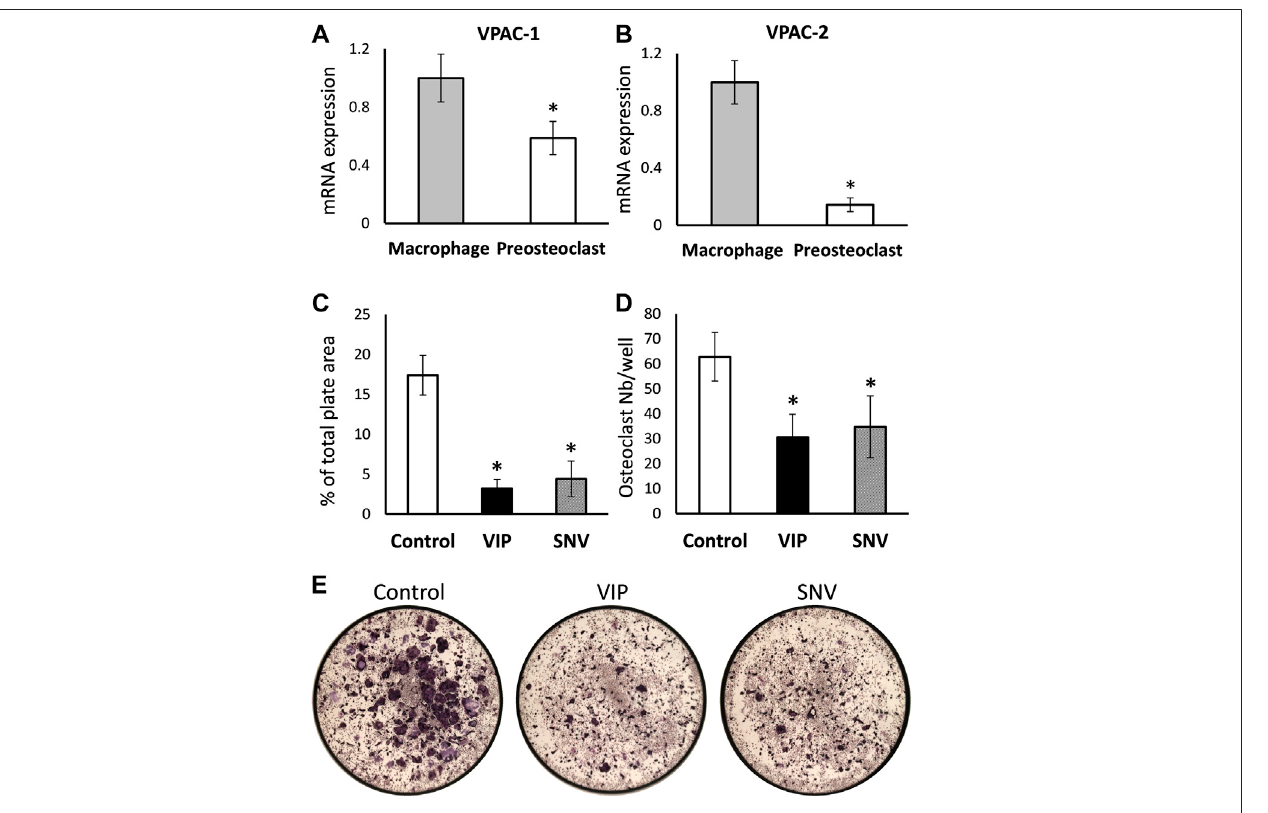
FIGURE3| DirecteffectofVIPandSNVonosteoclastogenesis. (A) VPAC1and (B) VPAC2expressioninM-CSFtreatedbonemarrow-derivedmacrophages(Day 0)andM-CSF+RANKLtreatedpre-osteoclasts (Day2)usingRT-qPCR.DataareMean ± SD,normalizedtoexpressionlevelsinmacrophages,performedintriplicatesin 2 independent experiments with similar results. *, p < 0.05 versus macrophages. (C-E) Osteoclastogenesis in the presence of 10 -6 M VIP, SNV or vehicle only (control) performedin96-wellplates;TRAP-positivemultinucleatedosteoclastswereevaluatedafter5daysofdifferentiation. (C) Osteoclast%surfaceareaand (D) number per well, Data are Mean ± SD, n (cid:2) 5, *, p < 0.01, ANOVA. (E) Representative images taken at a 2 × original magni fi cation (entire surface of well (cid:2) 0.32 cm 2